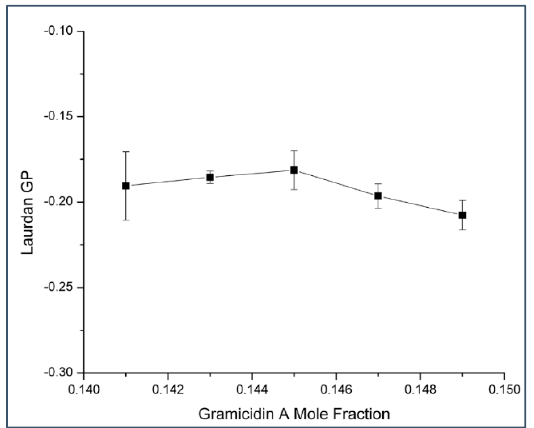
Figure 6. Laurdan’s generalized polarization (GP) versus gramicidin A mole fraction in gramicidin A/DMPC MLVs. Temperature = 37 °C. Error bars are the standard deviations of GP values obtained from three independently prepared samples.